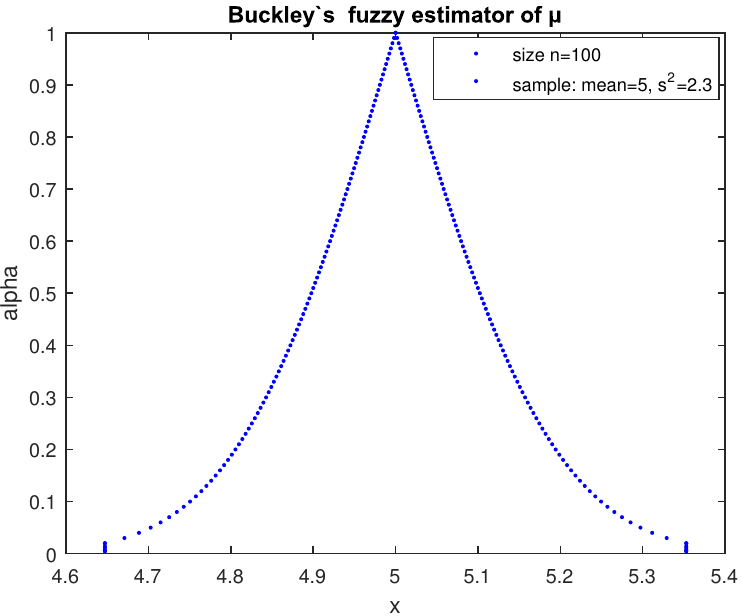
Figure 1. Buckley’s fuzzy estimator of the mean µ of a random variable X , which follows normal distribution with variance σ 2 = 2.3, derived from a sample of n = 100 observations with sample mean x =